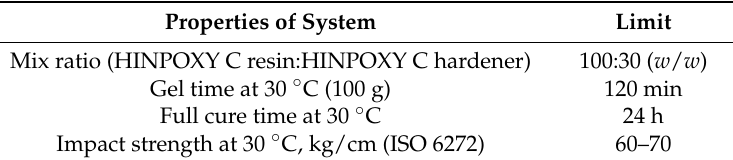
Table 4. User guide.